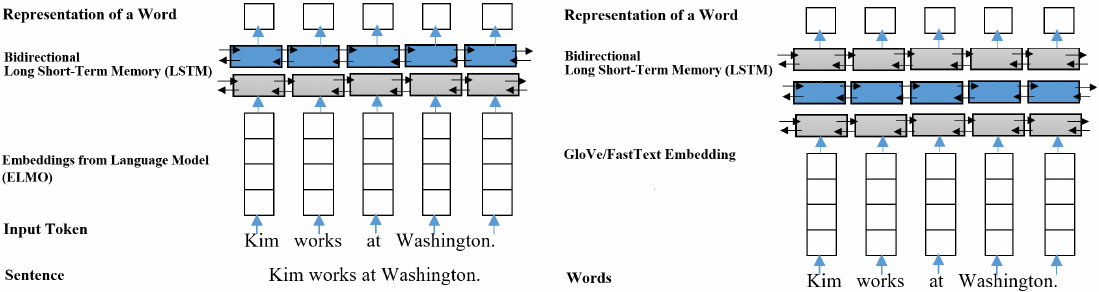
Figure 4. The pre-trained word embedding and contextual embedding passed through its own bidirectional LSTM